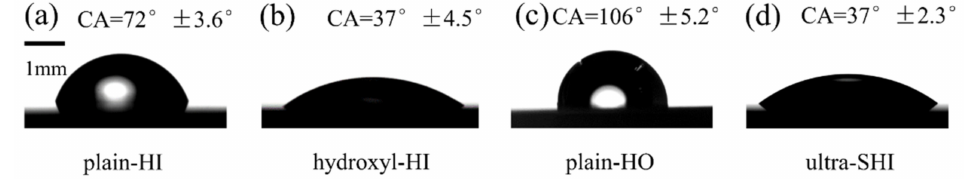
Figure 2. Surface wettability of the test surface. The static contact angle of a water droplet on the ( a ) plain-HI surface, ( b ) hydroxyl-HI surface, ( c ) plain-HO surface, and ( d ) ultra-SHI